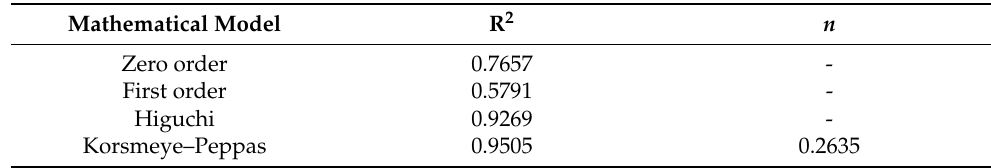
Table 3. Regression coefficients of mathematical models fitted to the release of CPX from ZeinCPX_HA NPs.